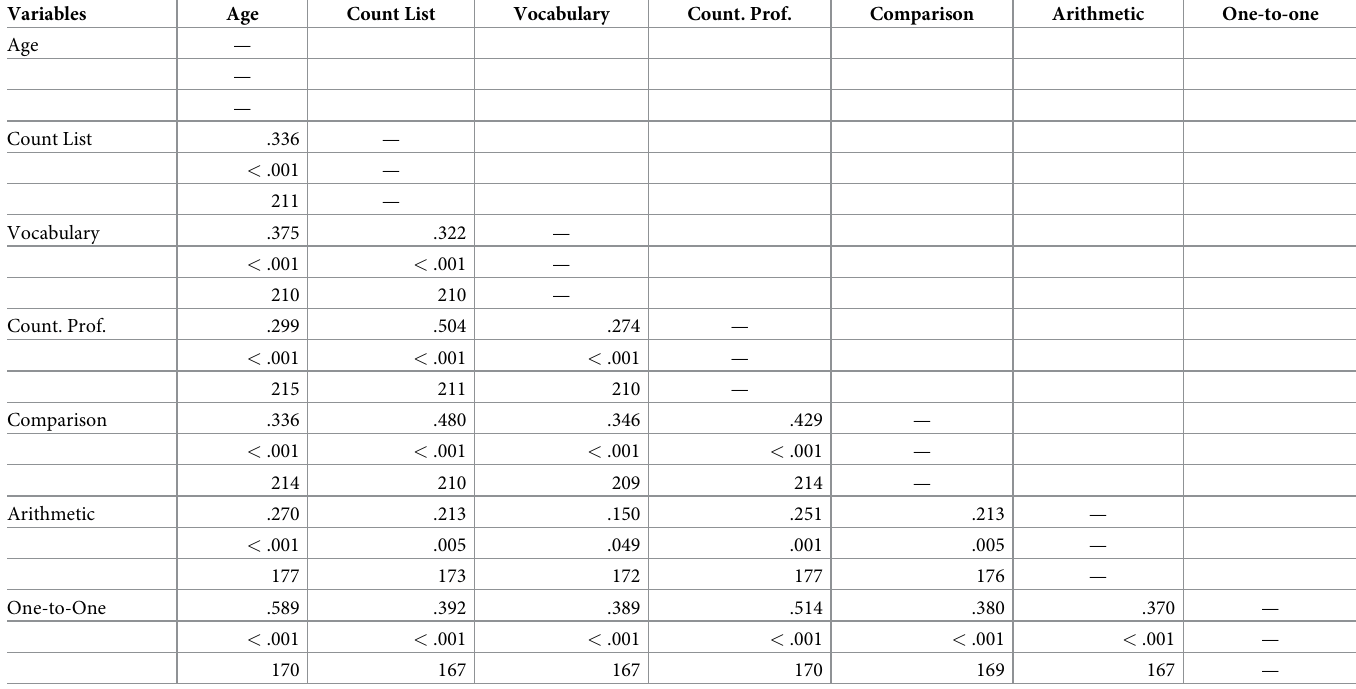
Table 1. Pre-training correlations between variables. Pearson’s correlation coefficient (r), p value, and number of participants included in the analysis reported in each cell. Vocabulary Count.